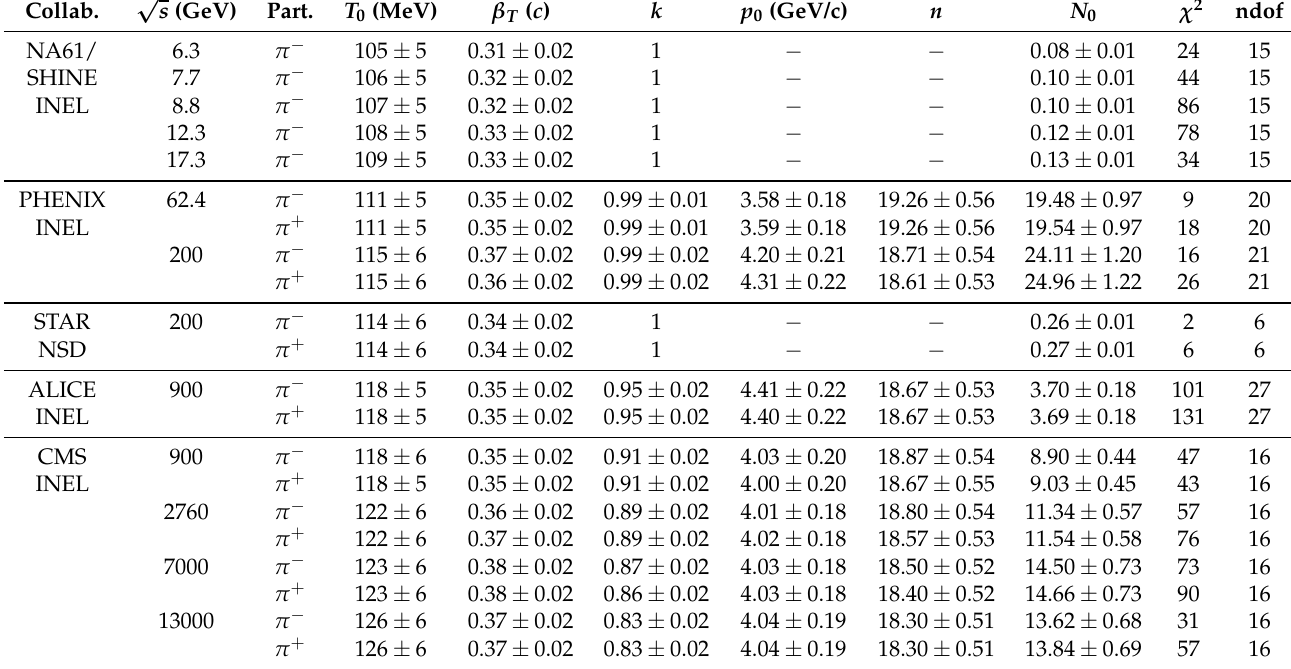
Table 3. Values of T 0 , β T , k , p 0 , n , N 0 , χ 2 , and ndof corresponding to the solid (dotted) curves for π − ( π + ) spectra in Figure 4, where Equation (8) through Equations (1) and (3) is